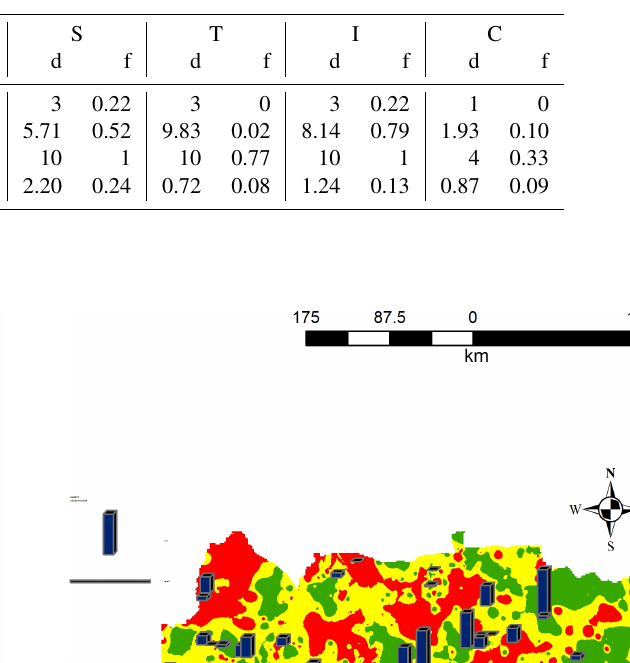
Table 9. Statistical summary of the seven parameters for the two methods.